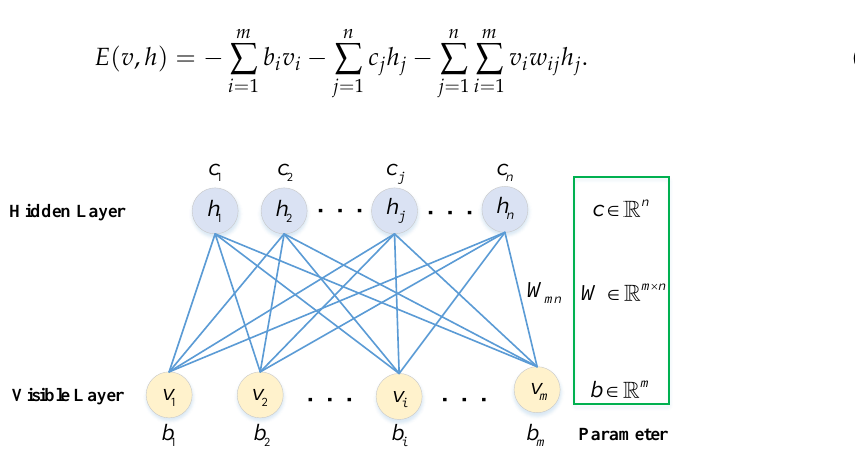
Figure 2. The graphical representation of an RBM with m visible nodes and n hidden